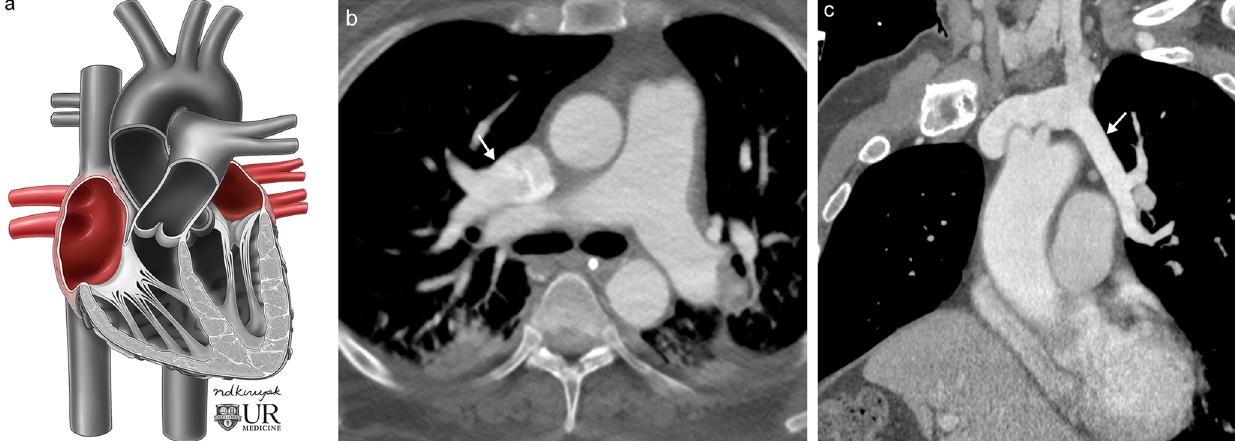
Fig. 12 Partial anomalous pulmonary venous return. a Conceptual illustration of partial anomalous pulmonary venous return. b Axial contrast-enhanced CT of an adult patient with partial anomalous venous return of the right upper lobe ( white arrow ) with blood flow returning to